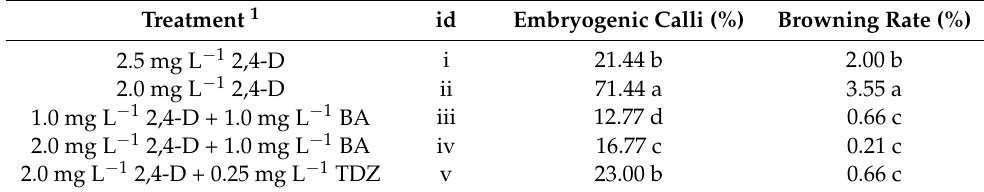
Table 1. Rice calli induction and browning rate from different induction treatments.